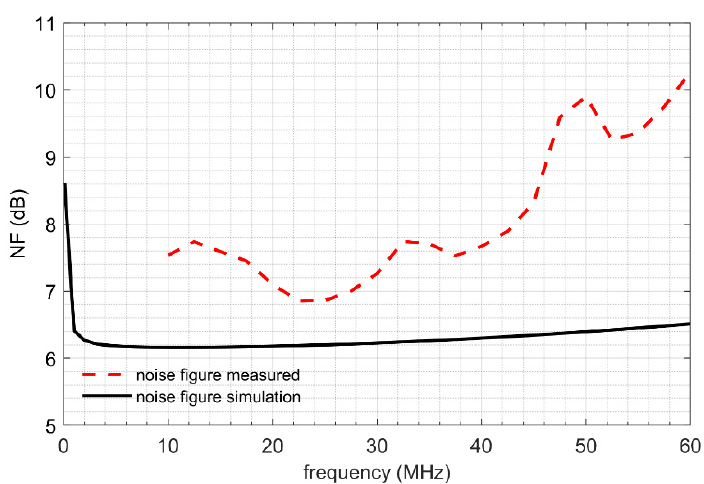
Figure 21. Comparison of measured and simulated noise figure—balun and